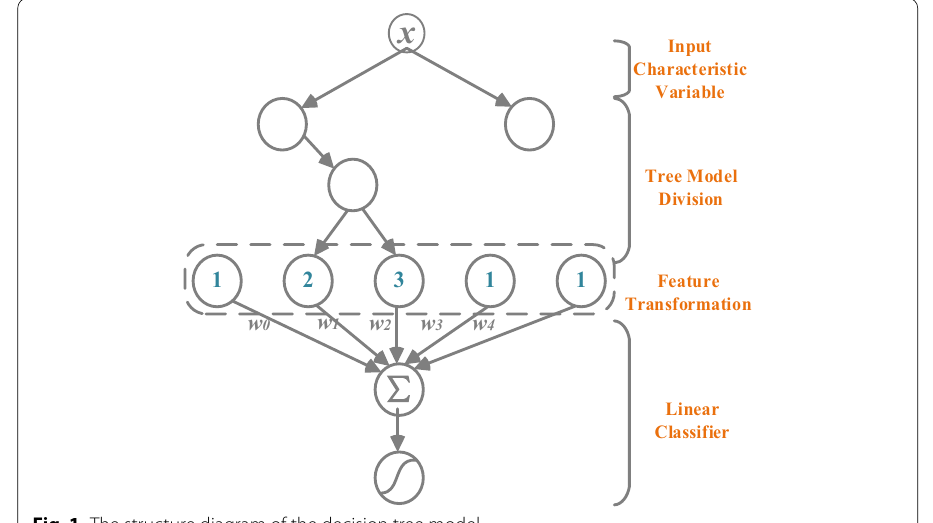
Fig. 1 The structure diagram of the decision tree model